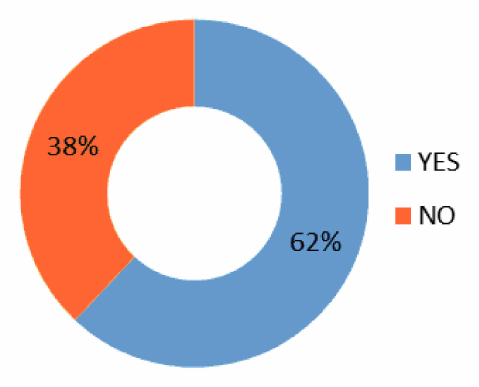
Figure 2. Are you currently reading a